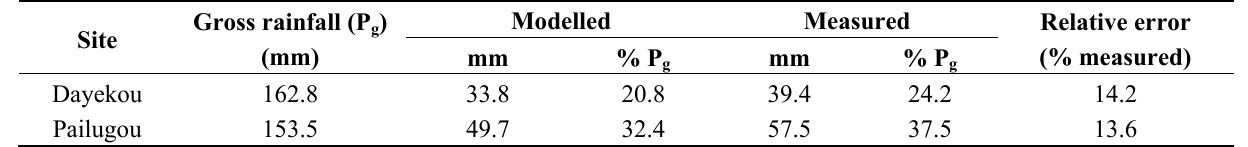
Table 3. The modelled and measured total interception loss at the two